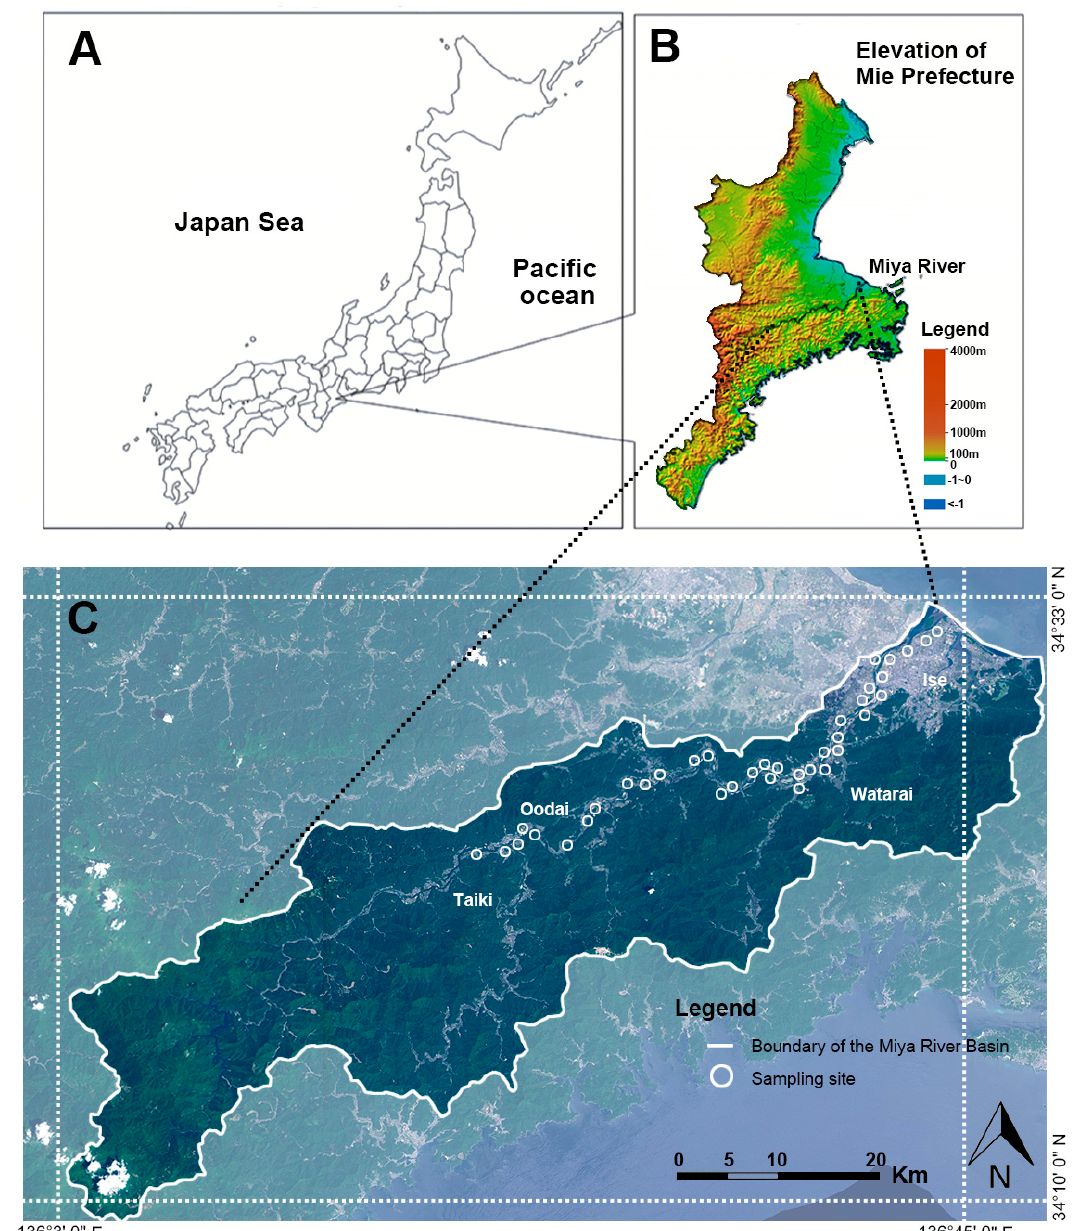
Figure 1. ( A ) Location of the Mie Prefecture. ( B ) Location of the Miya River and elevation map of the Mie Prefecture. ( C ) Area of the Miya River basin and the location of sampling plots.